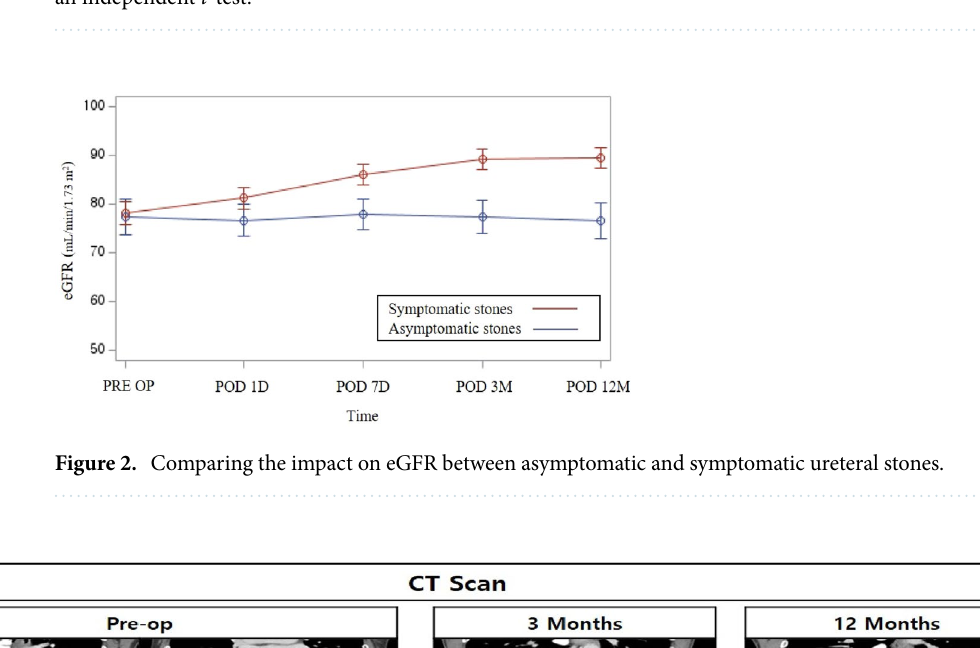
Table 4. Impact of asymptomatic and symptomatic stones on postoperative renal function. eGFR estimated glomerular filtration rate, PREOP preoperative, POD postoperative day, D day, M month. *The mean an independent t -test.